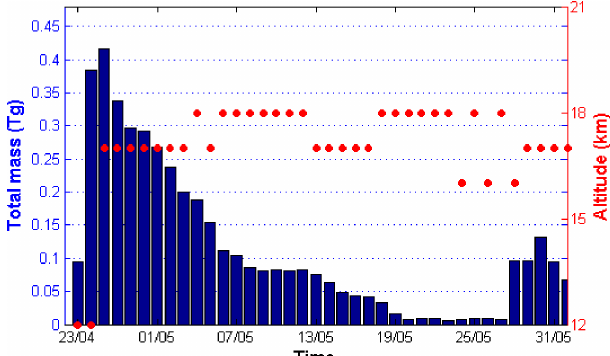
Figure 1. Evolution of the SO 2 total column mass (in blue) and the altitude of the maximum SO 2 mass (red dots) obtained from IASI from 23 April 2015 to 31 May 2015 over the Southern Hemisphere. The altitude of the maximum SO 2 mass was obtained from the al- gorithms detailed in Clarisse et al.